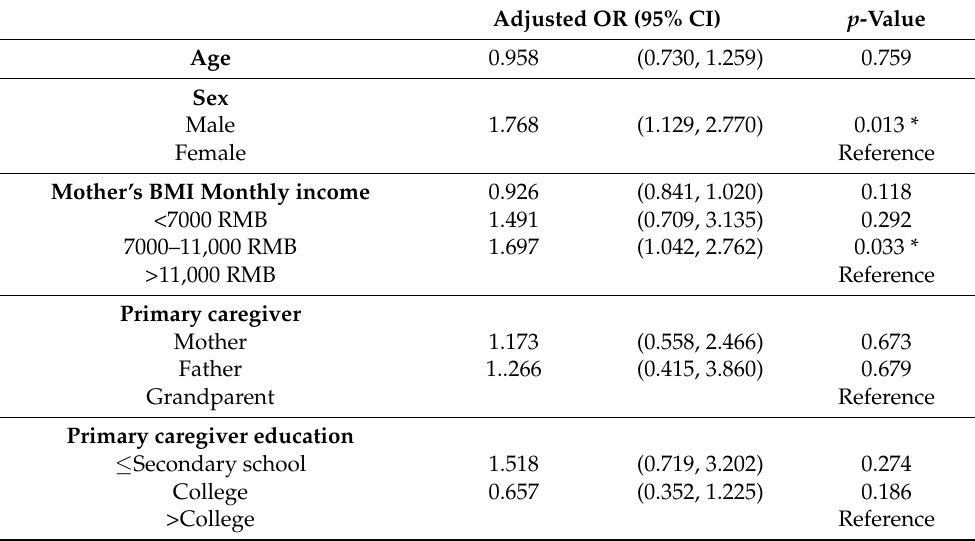
Table 4. Odds ratios for caregiver underestimation of child weight